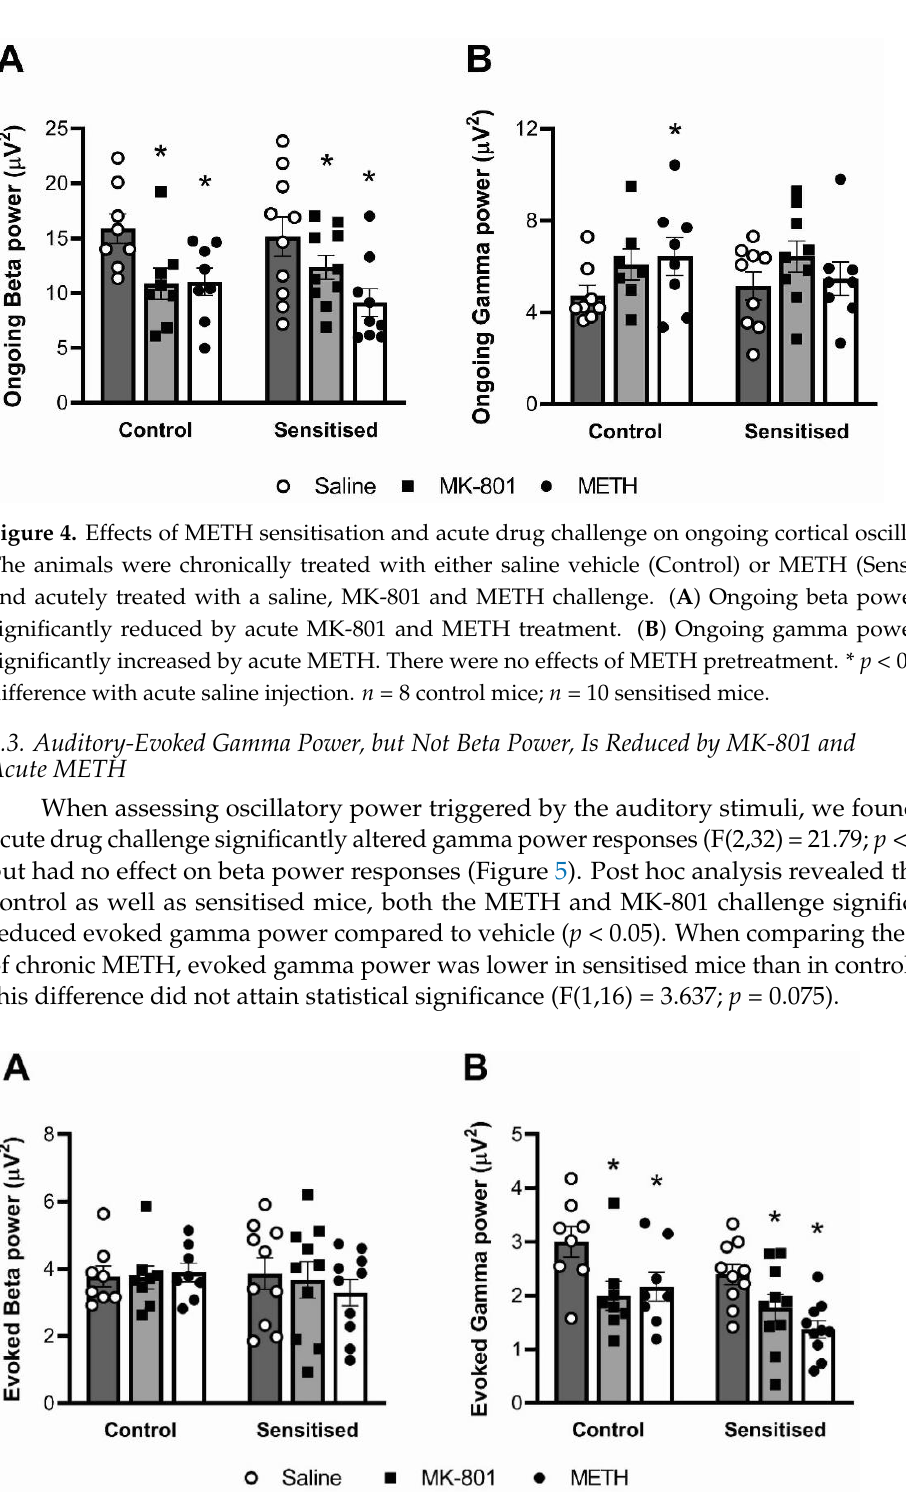
Figure 5. Effects of METH sensitisation and acute drug challenge on auditory-evoked cortical oscillations. Mice were chronically treated with either saline vehicle (Control) or METH (Sensitised) and acutely treated with a saline, MK-801 and METH challenge. ( A ) There were no effects of acute MK-801 or METH treatment on changes in beta power. ( B ) Both acute MK-801 and METH reduced evoked gamma power. There were no significant effects of METH pretreatment. * p < 0.05 for difference with acute saline injection. n = 8 control mice; n = 10 sensitised